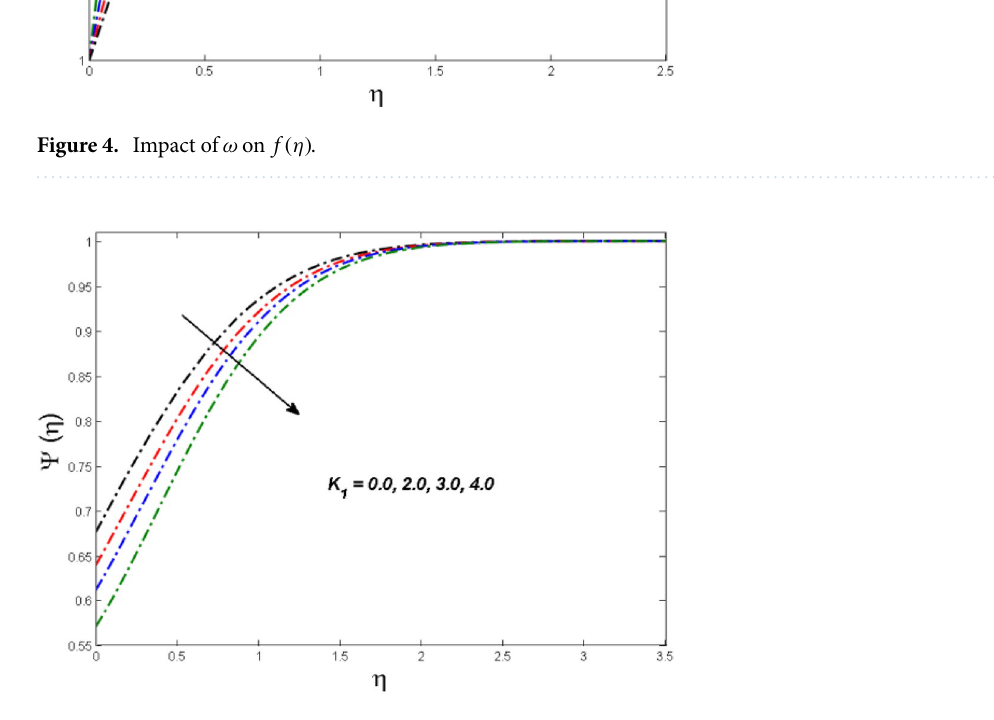
Figure 5. Effect of K 1 on �(η)